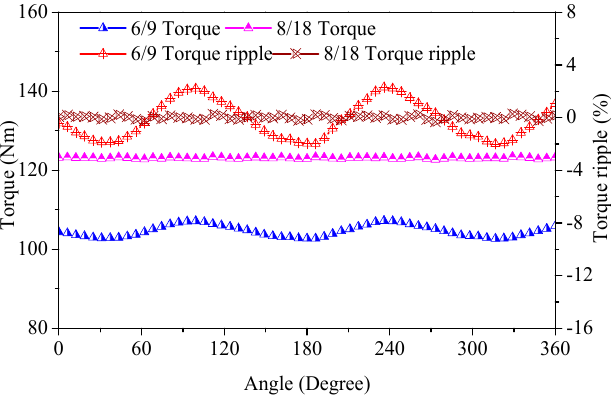
Figure 4. Torques and torque ripples with different pole-slot selection.